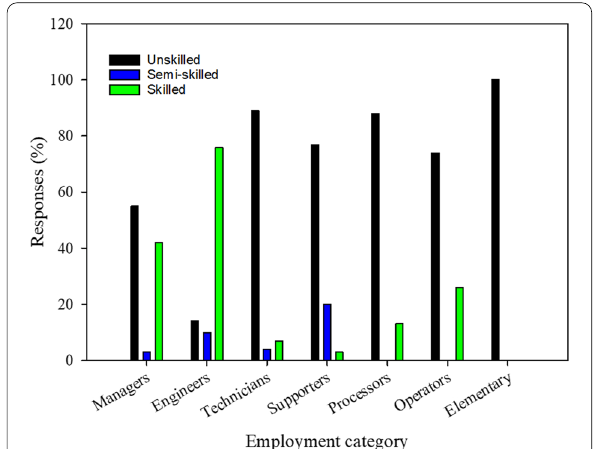
Fig. 5 Skills level by employment category in in tanneries and leather products